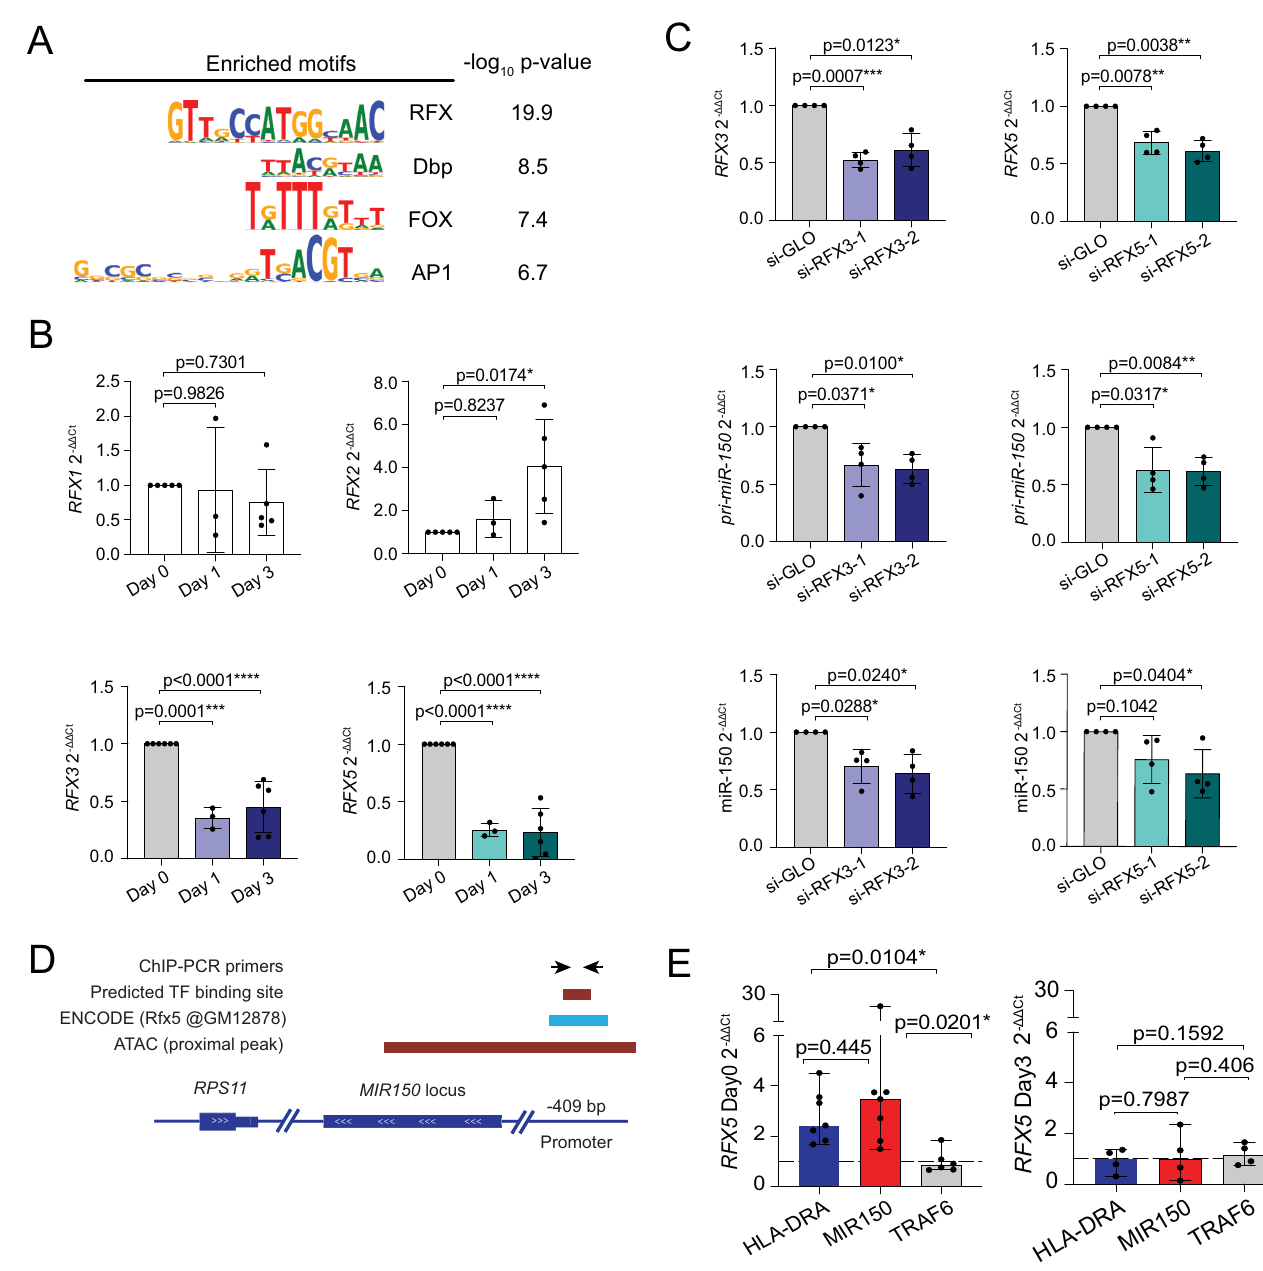
Fig 7. RFX factors regulate miR-150 expression. (A) Transcription factor motifs enrichment analysis. Peaks in cluster 2 were compared to all accessible sites detected. (B) Memory T lymphocytes were stimulated with plate-bound anti-CD3 and anti-CD28 antibodies for the indicated times. Total RNA was extracted and the expression of the different RFX mRNAs was measured by RT-qPCR. N = 3 to 6 independent donors (each dot represents one donor). Mean ± SD. One- way ANOVA. (C) Resting memory T lymphocytes were transfected with siRNAs targeting either RFX3 (left) or RFX5 (right). Twenty-four hours after transfection, total RNA was extracted and the expression of the indicated genes measure by RT-qPCR. N = 4 independent donors (each dot represents one donor). Mean ± SD. Paired t test, 2 tailed. (D) Schematic representation of the MIR150 locus, with overlapping ATAC peak and the location of an RFX5 ChIP- seq peak in the human B lymphocyte cell line GM12878 as described by the ENCODE project (ChIP-Atlas). The location of PCR primers for ChIP analysis of RFX5 binding is also indicated. (E) RFX5 binding at the indicated genomic loci was determined by ChIP-qPCR in resting (day 0) and activated (day 3) memory T lymphocytes. Data were normalized on the input and a control immunoprecipitation with an irrelevant antibody for each target (dashed line y = 1). Target genes exceeding the dashed line threshold were considered to be bound by RFX5. Data are shown as median with 95% confidence interval; at least N = 4 independent human donors. Each dot represents one experiment. Ratio paired t test, 2 tailed. Underlying data can be found in S1 Data. ChIP, chromatin immunoprecipitation; RT-qPCR, reverse transcription quantitative PCR; RFX, regulatory factor X; siRNA, small interfering RNA.